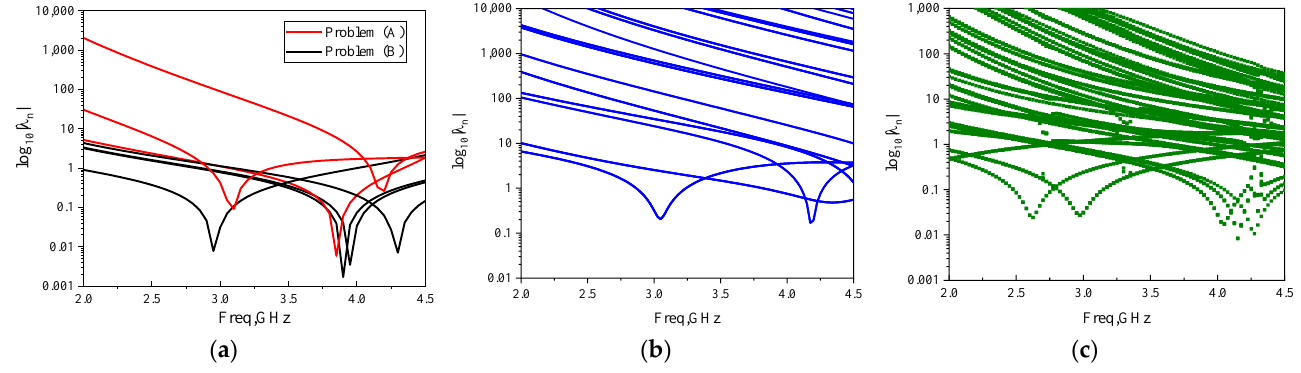
Figure 7. Magnitudes of characteristic eigenvalues in the frequency range from 2.0 GHz to 4.5 GHz for the four different problems. ( a ) Problems (A) and (B); ( b ) problem (C); ( c ) problem (D). Table 1. Resonant Frequency (GHz) for Four Different